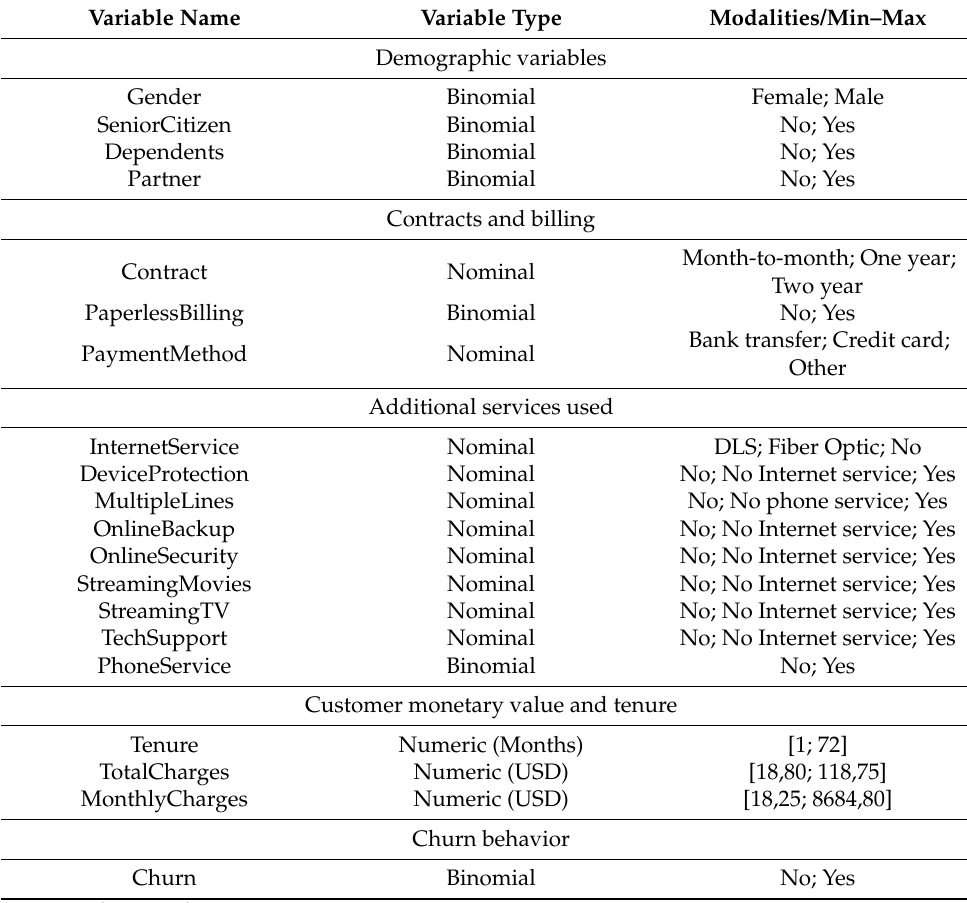
Table 1. Variables used in the